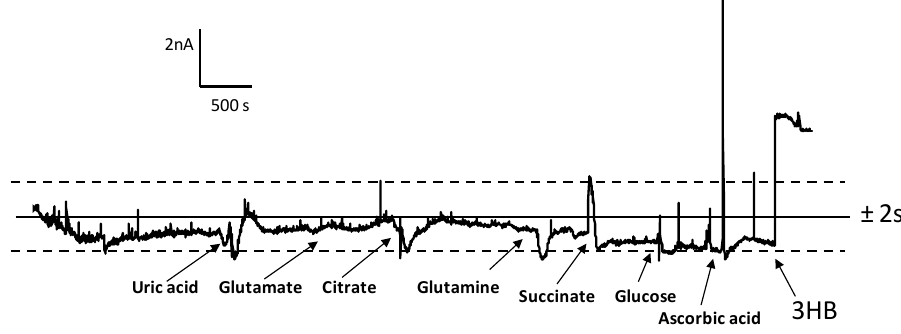
Figure 7. Amperometric responses obtained at the 3-HBDH/THI/rGO/SPCE biosensor for 0.178 mmol/L uric acid; 0.103 mmol/L glutamate; 0.060 mmol/L citrate; 0.067 mmol/L glutamine; 0.0083 mmol/L succinate; 0.0073 mmol/L glucose; 0.057 mmol/L ascorbic acid; 0.020 mmol/L 3-HB. Other conditions as in Figure 7.